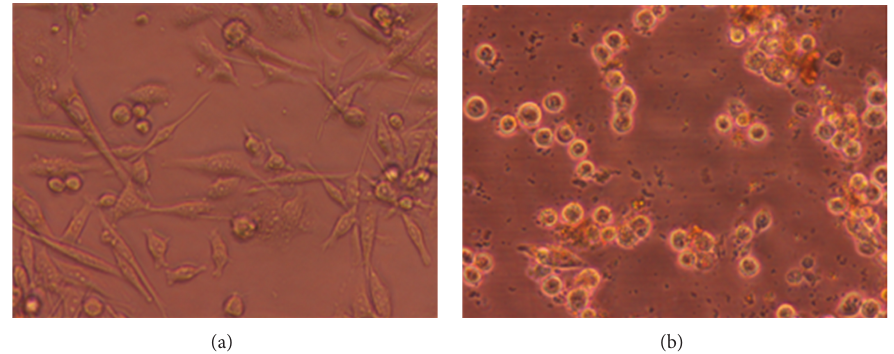
F 4: Morphological changes induced by the methanolic extract of E . platyloba on WEHI-164 cells (b) with 200 inhibition: IC50) aer 24h treatment and comparison with untreated controls (a). Data presented are the mean experiments.